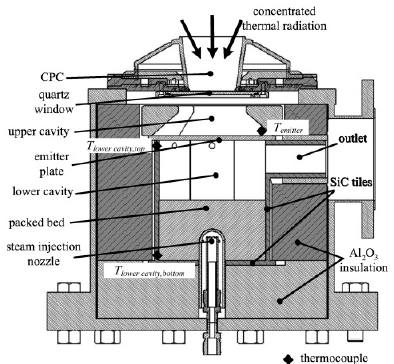
Figure 2. Schematic representation of the indirectly heated solar receiver/reactor designed by Piatkowski et al. Reprinted from [18] with permission from